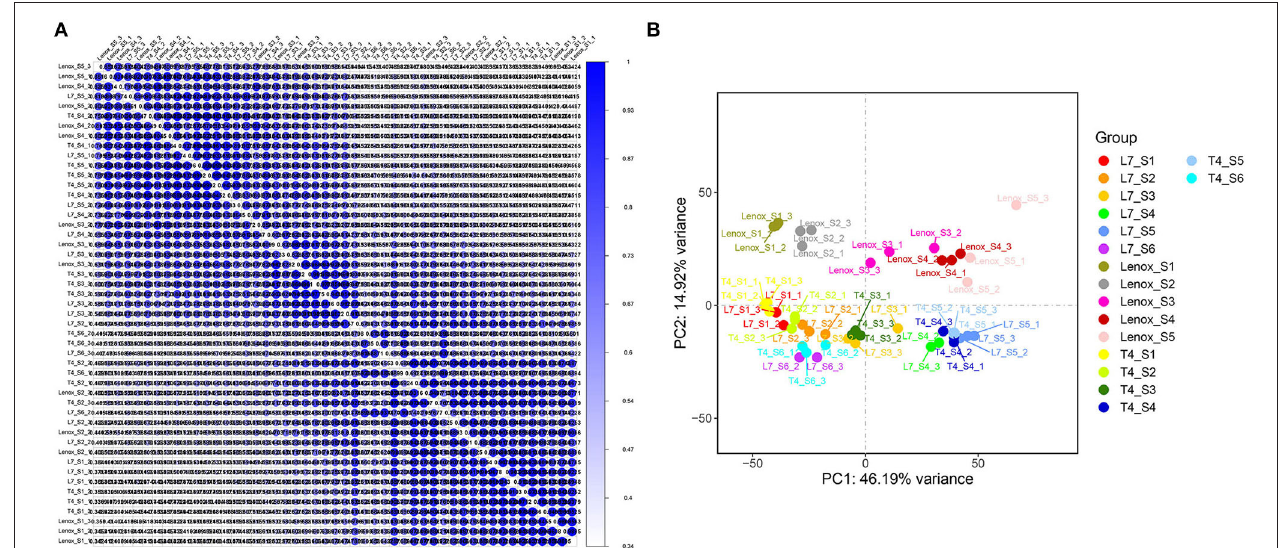
FIGURE 2 | Correlation analyses of RNA-Seq data in different stages of the three varieties. (A) Spearman correlation coefficient (SCC) analysis of different stages in Longyou-7 (L7), Tianyou-4 (T4), and Lenox. (B) Principal component analysis (PCA) analysis showing clustering of transcriptome s changes in different stages of